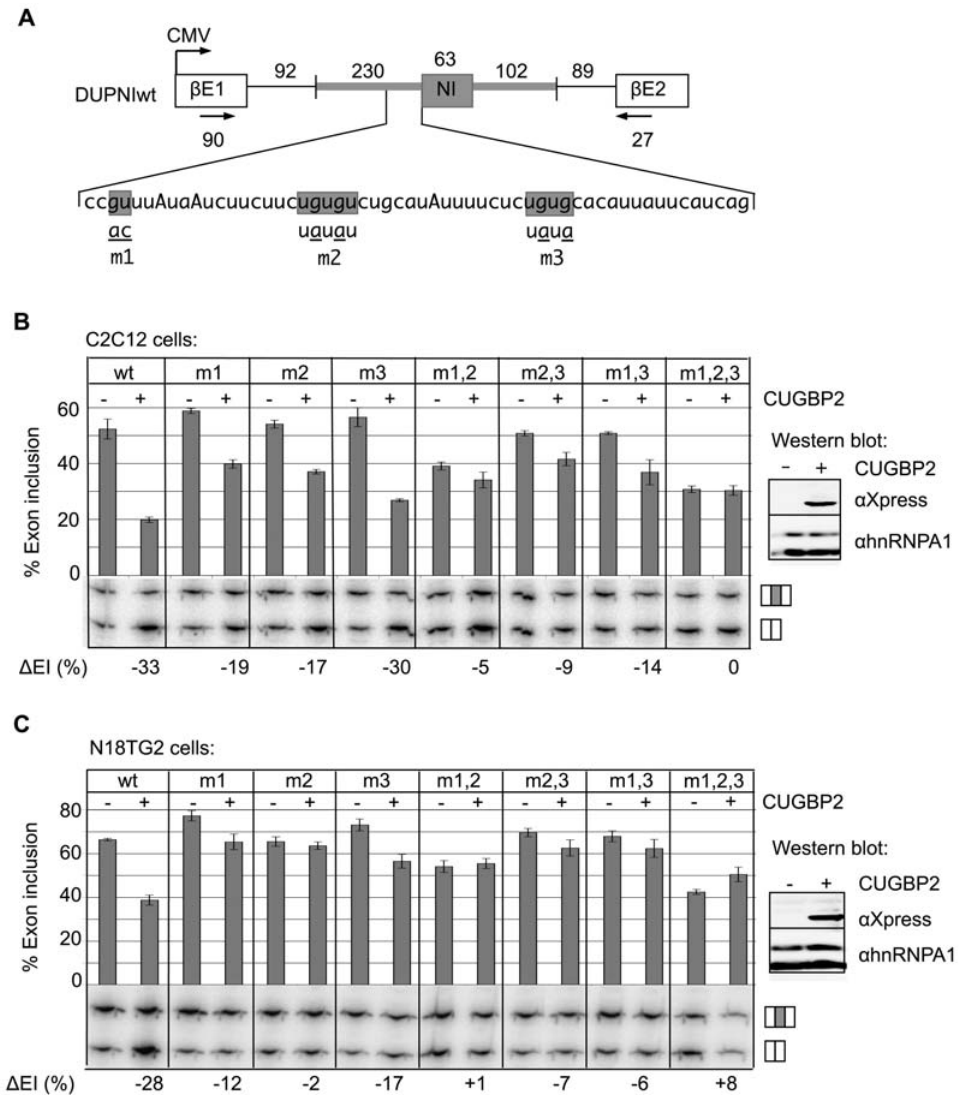
Figure 2. The UGUGU core motif and flanking GU dinucleotides are functionally important for CUGBP2 silencing. (A) Schematic of wild type and mutant versions of the DUPNI splicing reporter. The NI cassette exon (shaded rectangle) and regions of the native flanking introns (shaded lines) were inserted between b -globin exons b E1 and b E2 downstream of a CMV promoter. Nucleotide lengths in base pairs are indicated above and below schematic. Sequence shows an expanded view of the NI 3 9 splice site region with mutations m1, m2, and m3 indicated by underscores below the shaded regions. Arrows indicate the location of primers used for RT-PCR amplification of exon included and skipped mRNAs. (B) Splicing reporter expression in C2C12 cells. Splicing reporters with no mutation (wt), with single (m1, m2, m3), or combined (m1,2, m2,3, m1,3, m1,2,3) mutations were expressed with vector backbone control ( 2 ) or with pcDNA4/CUGBP2 expression vector ( + ). The gel panel is a representative polyacrylamide gel image with the top band corresponding to the exon included and the bottom band corresponding the exon skipped mRNA. The bar graph shows the percent exon inclusion as an average of three separate experiments. The change in percent exon inclusion ( D EI) as a function of CUGBP2 expression is shown below the gel panel. Inset: Western blot analysis was used to verify Xpress-tagged CUGBP2 expression; endogenous hnRNPA1 was a loading control. (C) Experiments were as in (B) except N18TG2 cells were used.